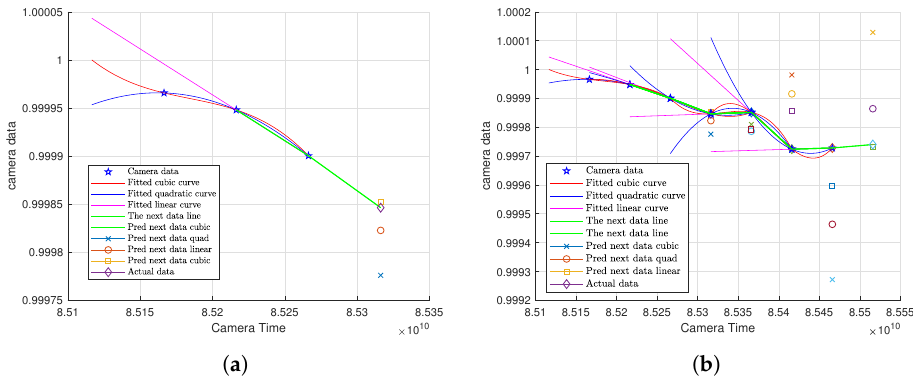
Figure 3. The fitted cubic, quadratic, and linear curves and the predicted next data from the ( a ) first four data points and ( b ) first seven camera